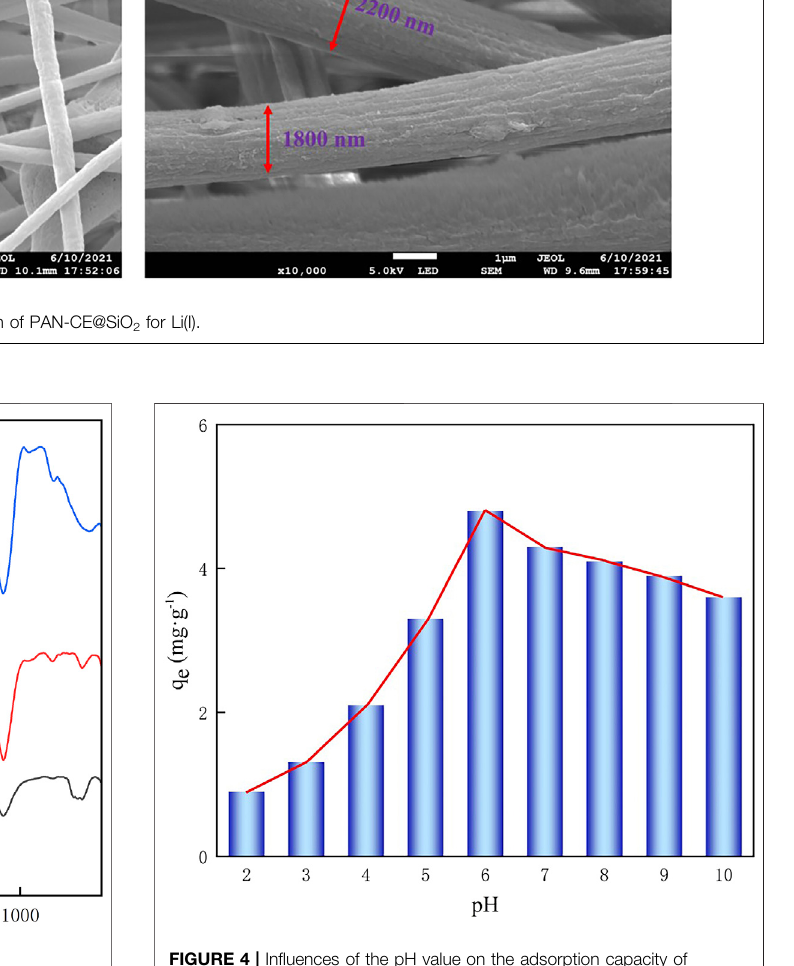
FIGURE 4 | In fl uences of the pH value on the adsorption capacity of PAN-CE@SiO 2 for